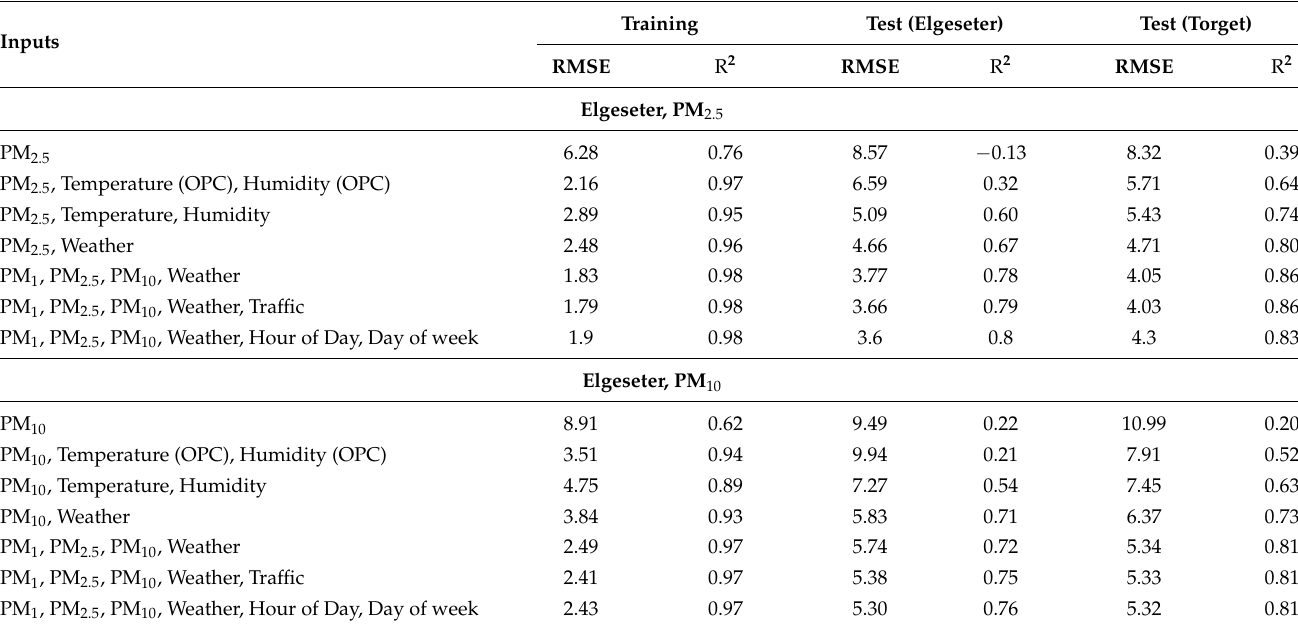
Table 3. Calibration results with both prediction and classification